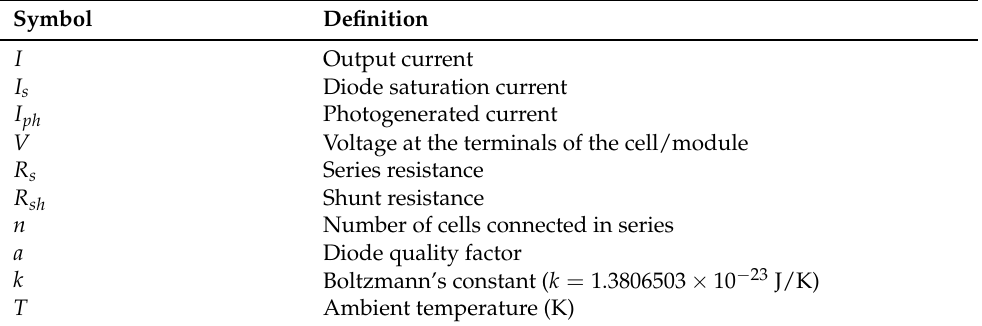
Table 2. Definition of the symbols used in Equation (3).